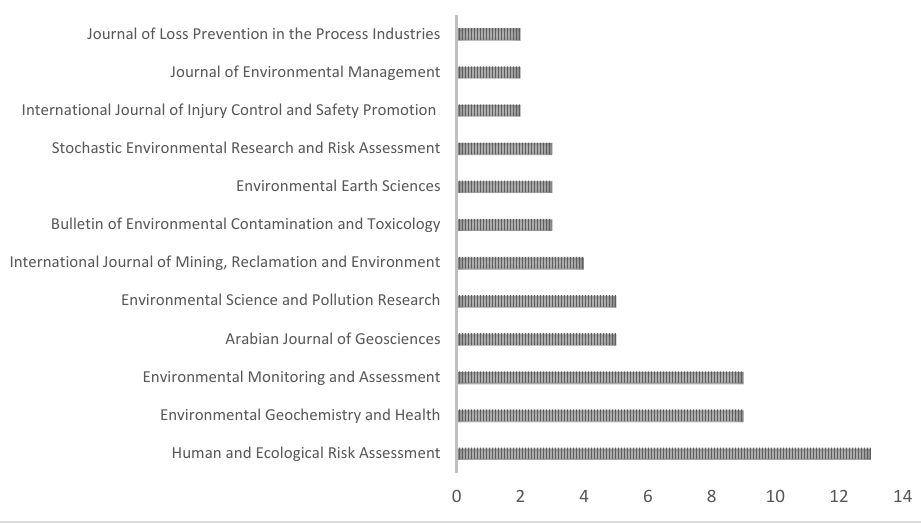
Figure 6. Number of papers in each investigated journal (for journals with at least two published papers from the analyzed 94 articles).